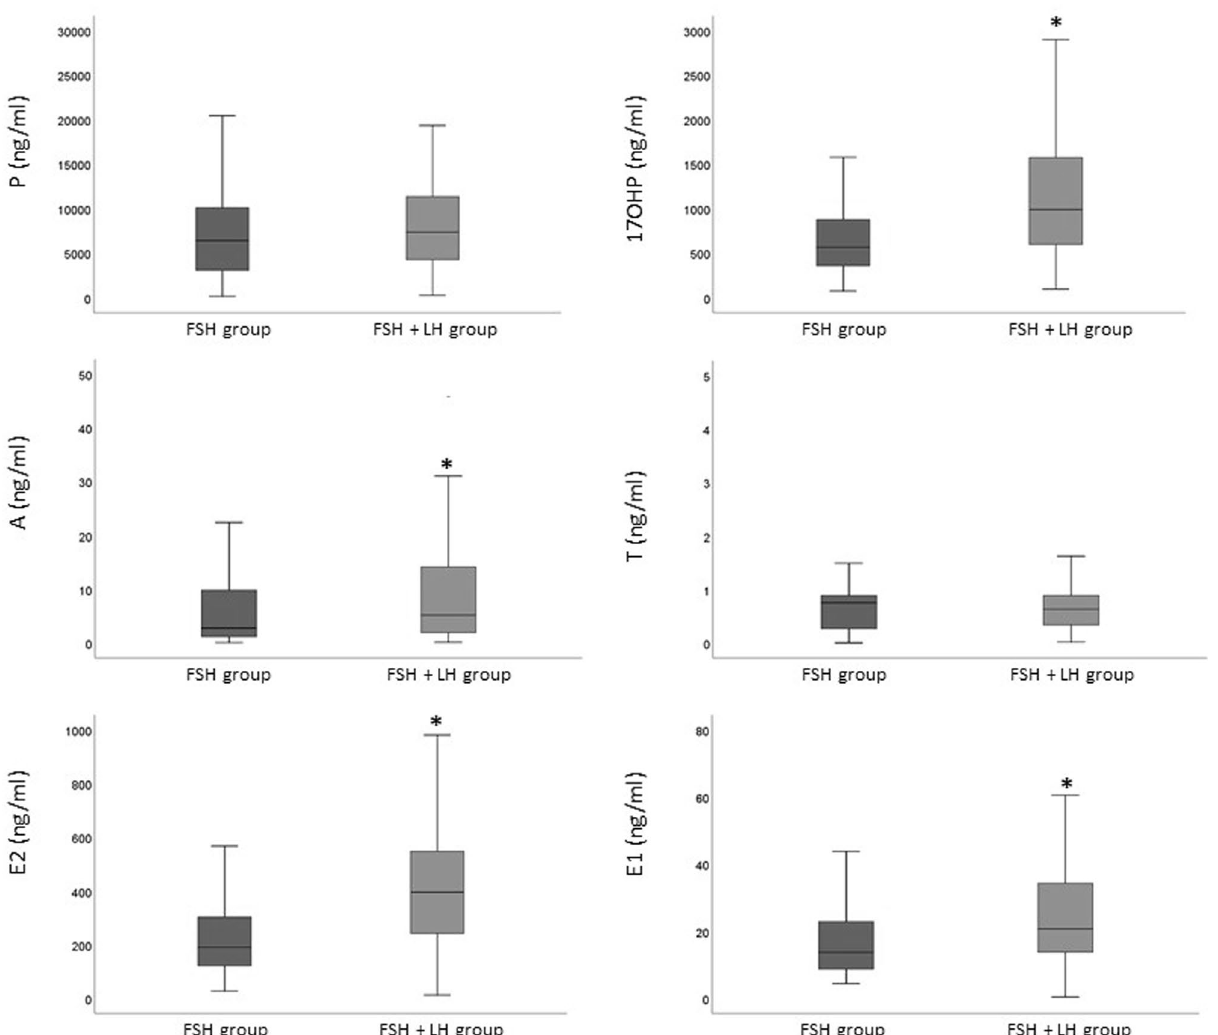
Figure 3. Box plots of median (IQR) FF levels of Progesterone (P, upper left panel), 17α-Hydroxyprogesterone (17-OH-P, upper rightpanel), Androstenedione (A, middle left panel), Testosterone (T, middle right panel), Estradiol (E2, lowerleft panel) and Estrone (E1, lower right panel) levels in mature (MII) oocytes, in the two groups of ovarian stimulation. *p < 0.05 vs FSH